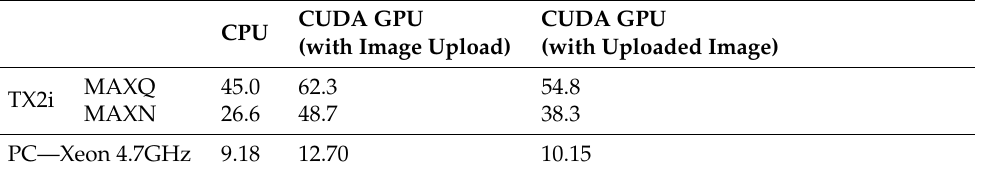
Table 1. Pre-processing times, in ms with a median filter and shadow detection.